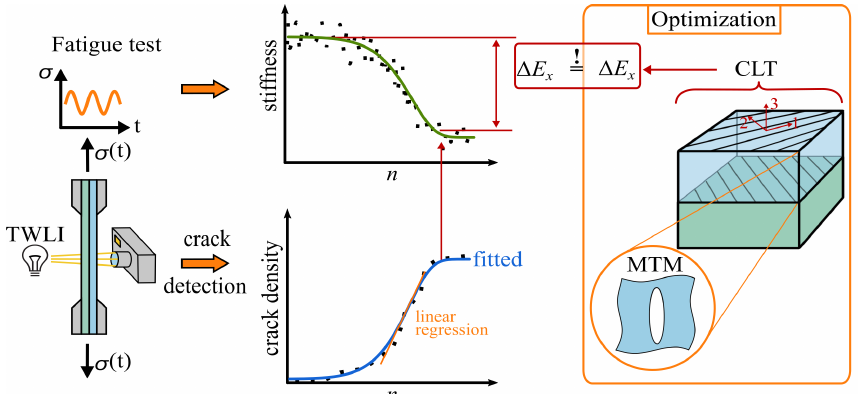
Figure 5. A schematic representation of the correlation process. The stiffness and crack density is evaluated in fatigue tests. The needed inclusion volume fraction is optimized to yield the same stiffness degradation as observed in the experiment. With Equation (4), the correlation constant is then computed from the experimental saturation density.